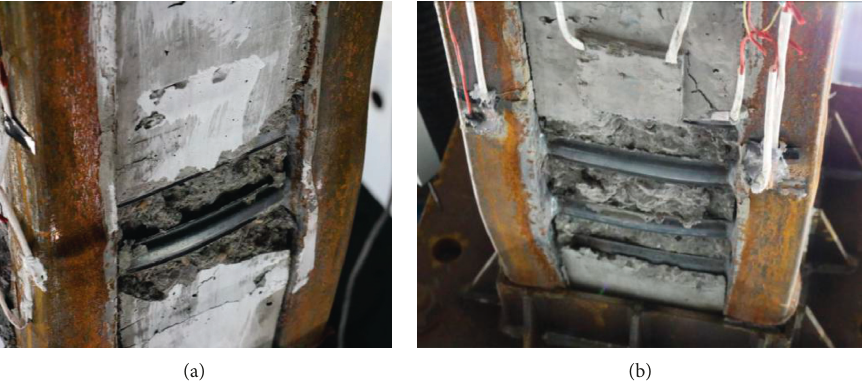
Figure 12: Failure state and crack distribution of the specimen.